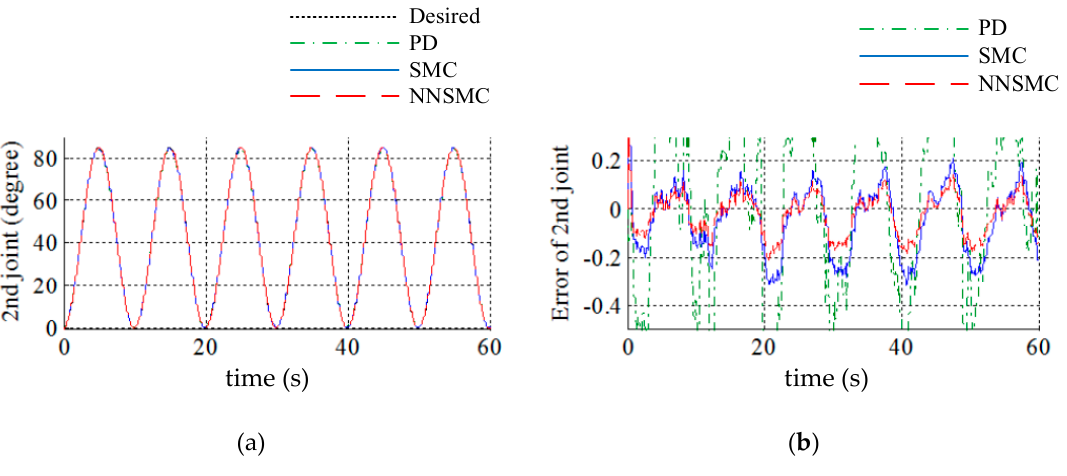
Figure 6. Comparison of tracking performance of the first joint: ( a ) tracking position, ( b ) tracking error.